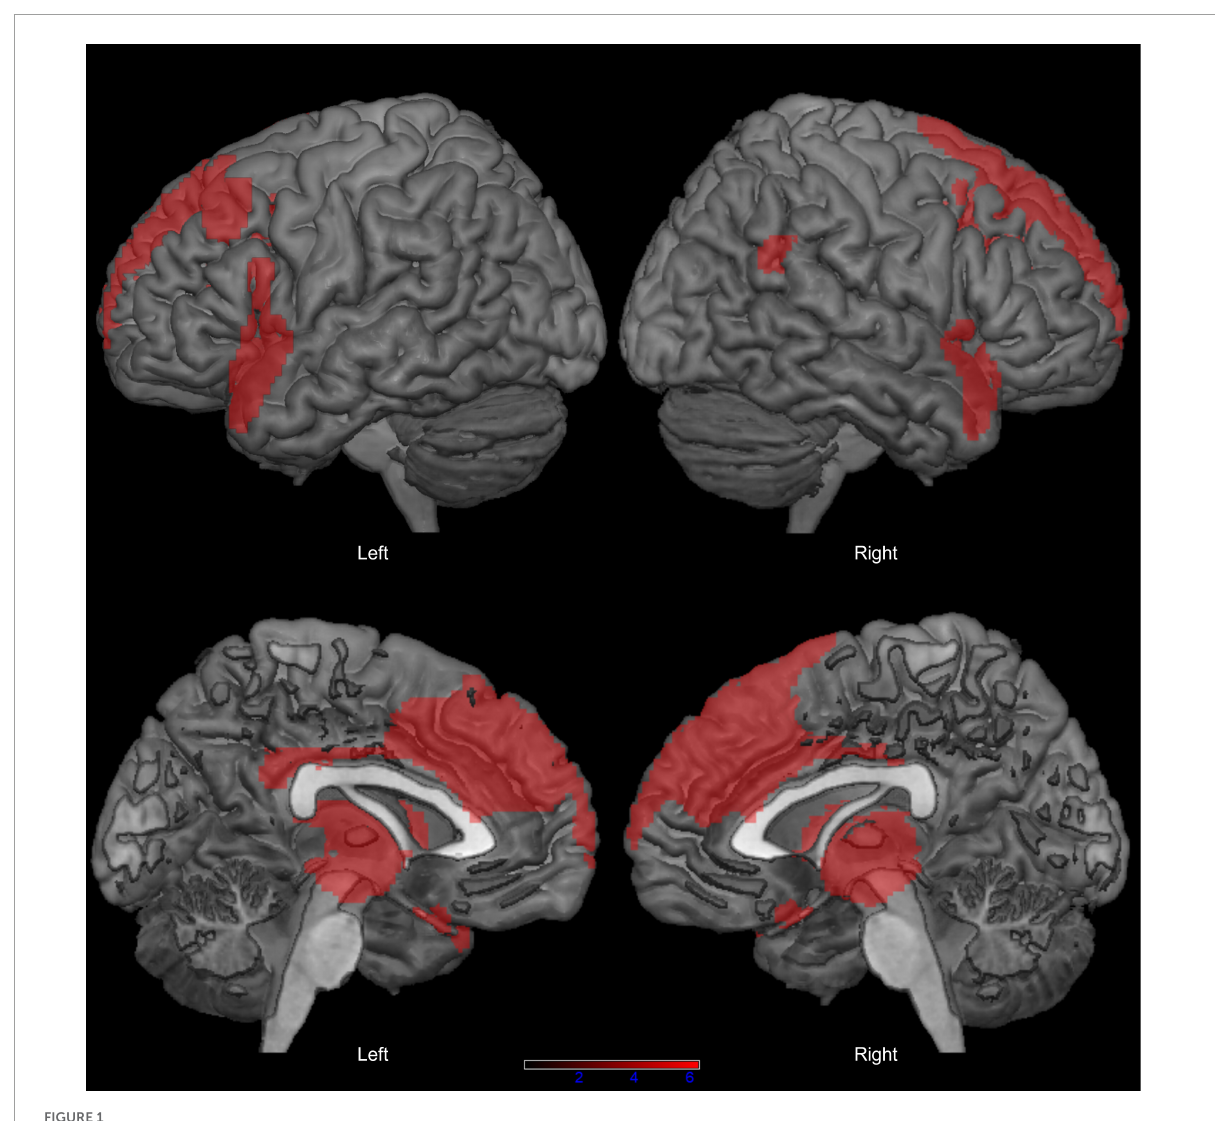
FIGURE1 Distribution of hypometabolism in patients with progressive supranuclear palsy (PSP) compared with healthy controls ( p < 0.05 family-wise-error corrected, minimum cluster size: 100